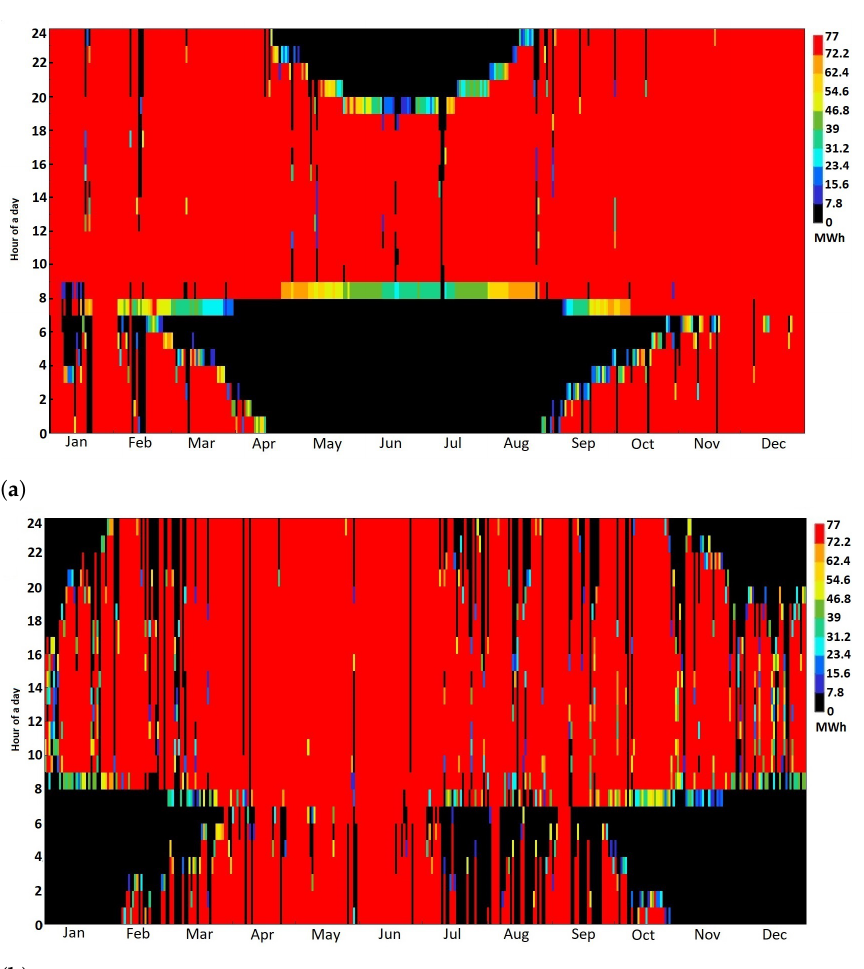
Figure 9. Average monthly time behavior of the gross energy generation. ( a ) Site 1 case. ( b ) Site 2